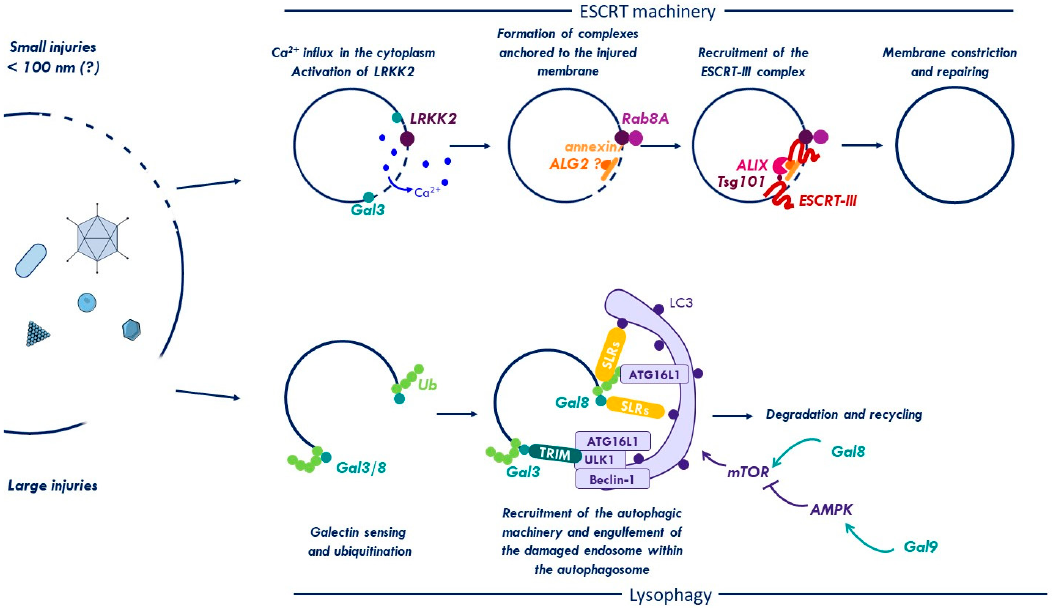
Figure 2. Membrane damage repair and removal. The endosome is constantly challenged by pathogens (bacteria, virus, and fungi), protein aggregates, or chemicals that can disrupt its membrane and provoke injuries of di ff erent sizes. Small disruptions ( < 100 nm) trigger a leakage of Ca 2 + into the cytoplasm and activate LRKK2. LRKK2 and Ca 2 + e ff ectors mediate the recruitment of the ESCRT machinery to promote repair of the injured organelle. Galectin-3 (Gal3) is recruited to damage sites and may promote ESCRT assembly. If the injury is too large, the cell will trigger a process of degradation called lysophagy. During lysophagy, damaged vacuoles are sensed and tagged by galectins (Gal) and ubiquitin (Ub). Both signals mediate the recruitment of the autophagic machinery (either directly via autophagic receptors, such as the sequestosome like receptors (SLRs) or indirectly via TRIMs). The membrane remnant is engulfed in a double-membrane vesicle called autophagosome, which fuses with lysosomes for content degradation and recycling. Autophagy is also controlled by metabolic kinase mechanistic target of rapamycin (mTOR) through Gal8. Moreover, Gal9 can also control autophagy induction by directly activating AMP-activated protein kinase (AMPK) in response to endosomal damage to inhibit mTOR. See text for details. Abbreviations: ESCRT, endosomal sorting complexes required for transport; Gal8, galectin8; LRRK2, Leucine-rich repeat kinase 2; ROS, reactive oxygen species; Ub, ubiquitin.